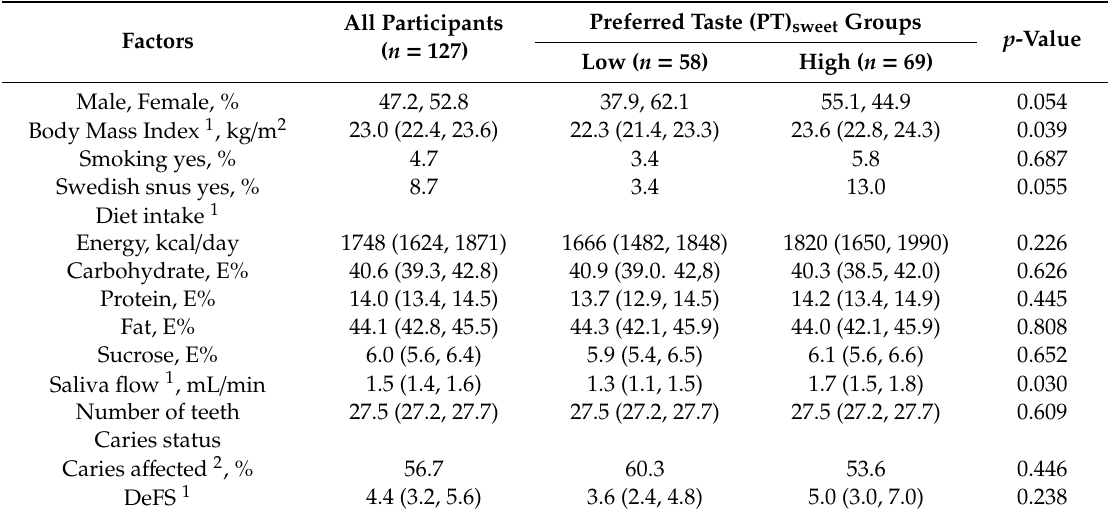
Table 1. Participant characteristics. Data are shown for all participants and when split by preferred concentration of sweet (PT sweet ). Di ff erences in subject distributions in the PT sweet groups were tested with Chi 2 test, and between means with Student’s t